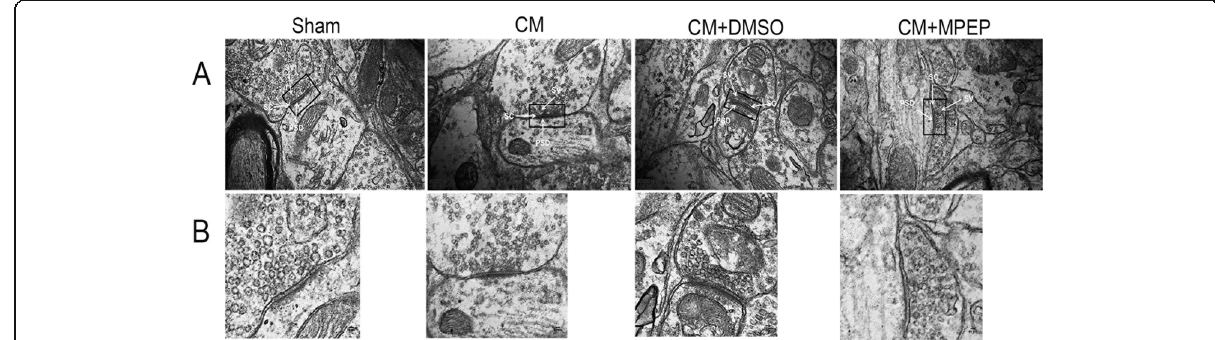
Fig. 5 Changes of synaptic ultrastructure. a Synaptic ultrastructure in the different groups. (Scale bars = 200 nm) b Magnification of the black rectangle frame from a. (Scale bars = 80 nm; n = 4 each group; PSD,postsynaptic density; SC,synaptic cleft; SV, synaptic vesicle)